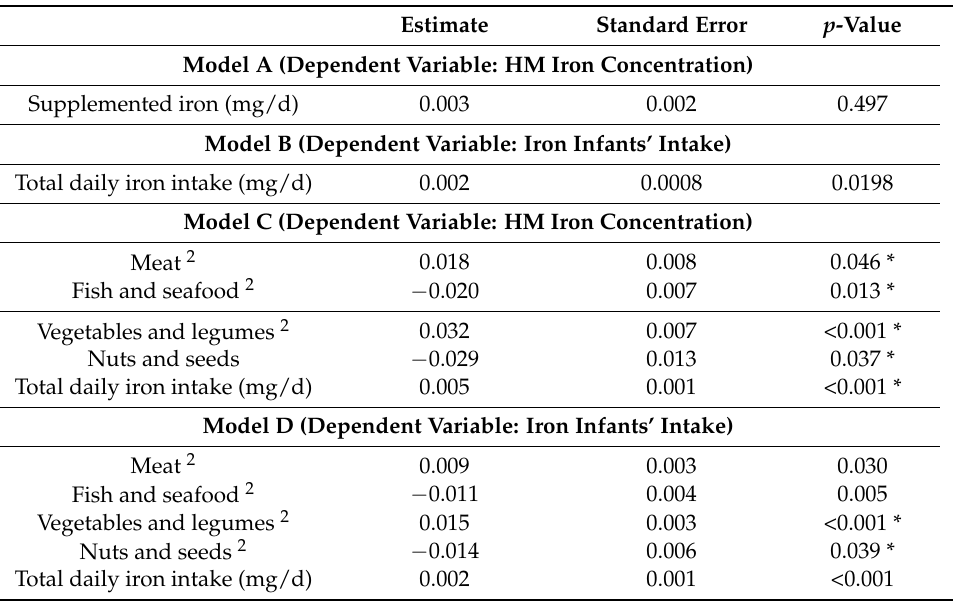
Table 7. Results of multivariable linear regression analysis for prediction of HM iron concentration (Model A and Model C) and infants iron intake (Model B and D) 1 .